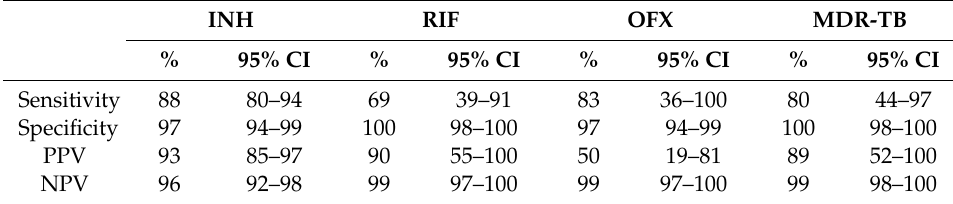
Table 1. Performance of MTBDR plus testing on sputum samples compared with culture-based drug negative predictive value. OFX = ofloxacin / moxifloxacin. PPV = positive predictive value. RIF =